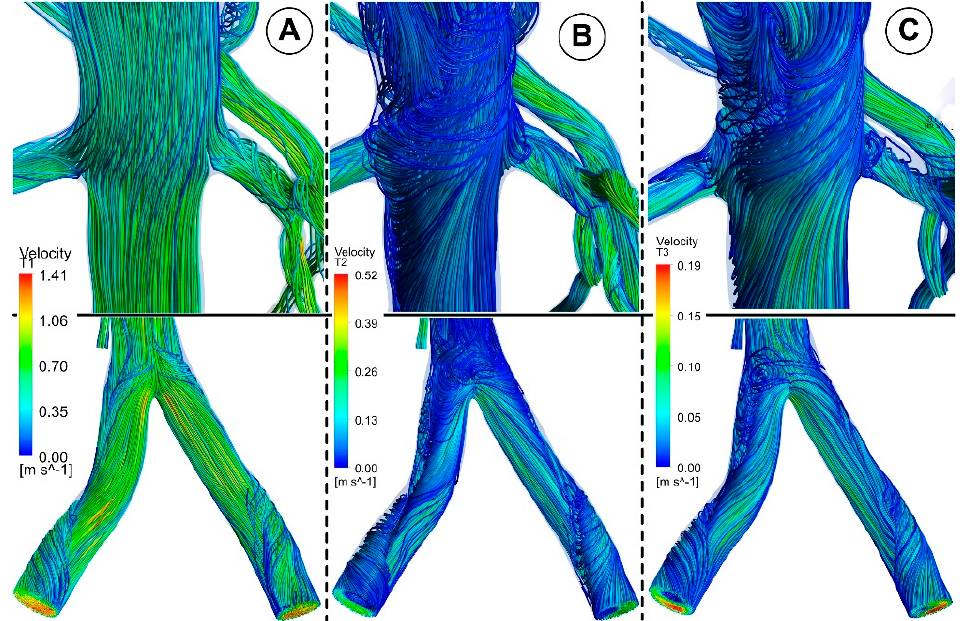
Figure 14. Recirculation development during different time steps ( A ) time T1 = 0.15 s; ( B ) time T2 = 0.45 s; ( C ) time T3 = 0.6 s in; renal arteries bifurcation ( upper row ) and iliac artery bifurcation ( lower row ).